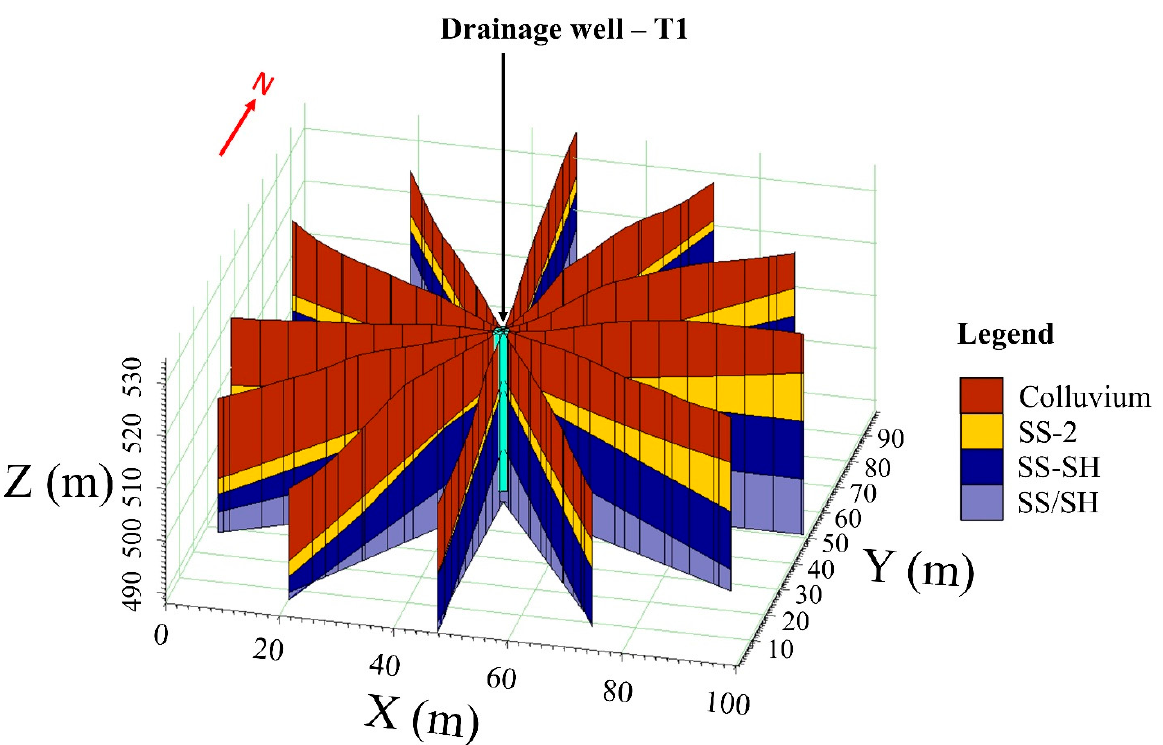
Figure 18. Three-dimensional profiles based on the 3D EGM and the drainage well T1 within the Huafan University campus. There are six profiles at 30-degree intervals. T1 has a depth of 30 m is positioned in the center of each profile.